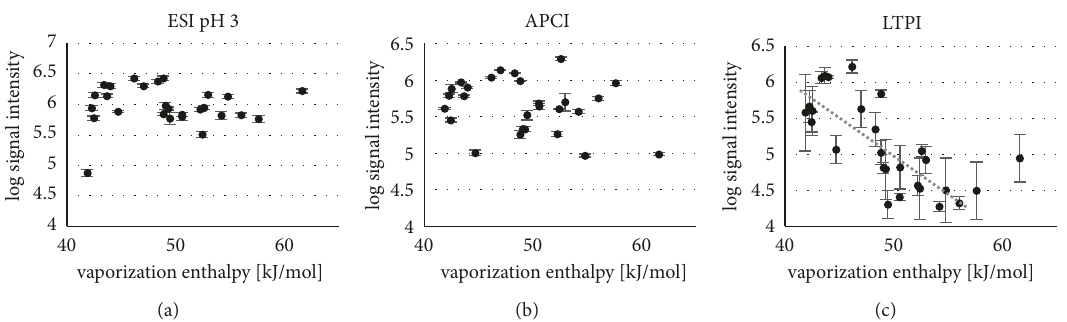
Figure 7: Signal intensity of LTPI measurements of chlorpyrifos as a function of the analyzed surface.